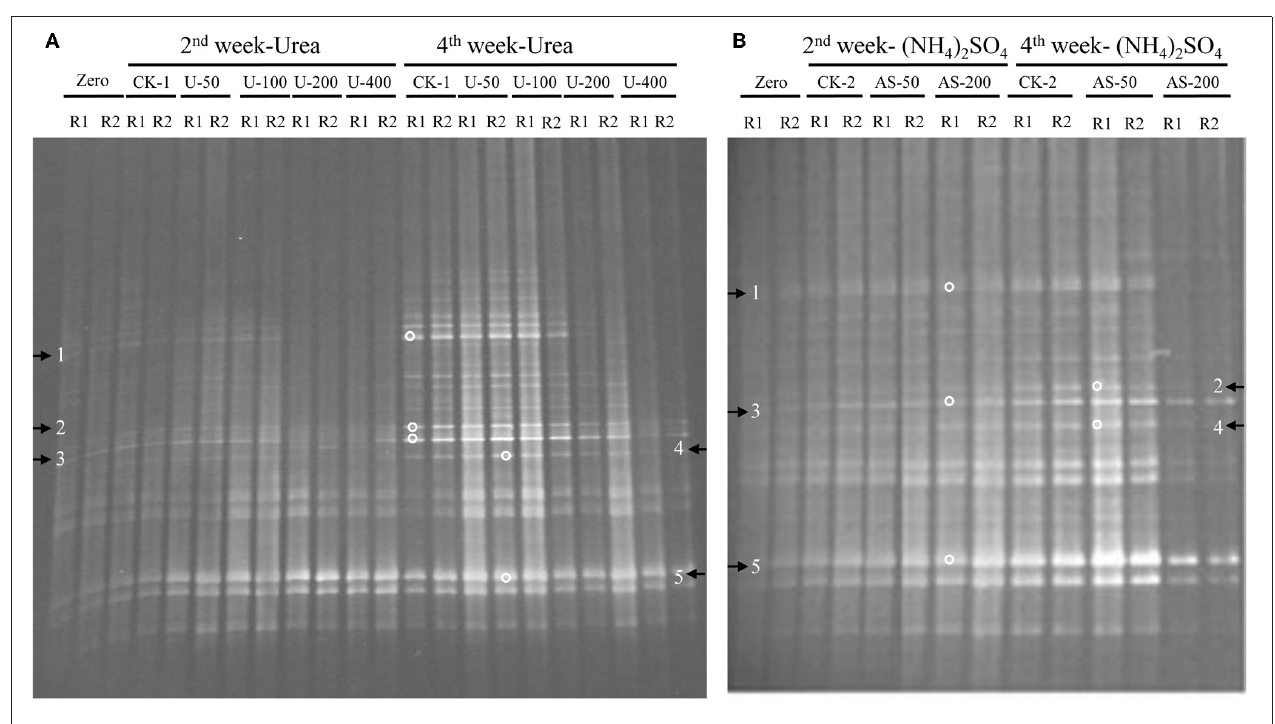
FIGURE 6 | DGGE fingerprints of the archaeal amoA gene in the soil microcosms amended with urea (A) and ammonium sulfate (B). The arrows indicate DGGE bands excised for